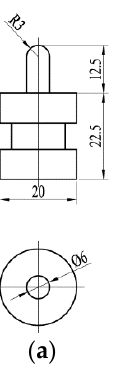
Figure 6. ( a ) Size of the probe and ( b ) HSP-540 concrete shrinkage dilatometer.